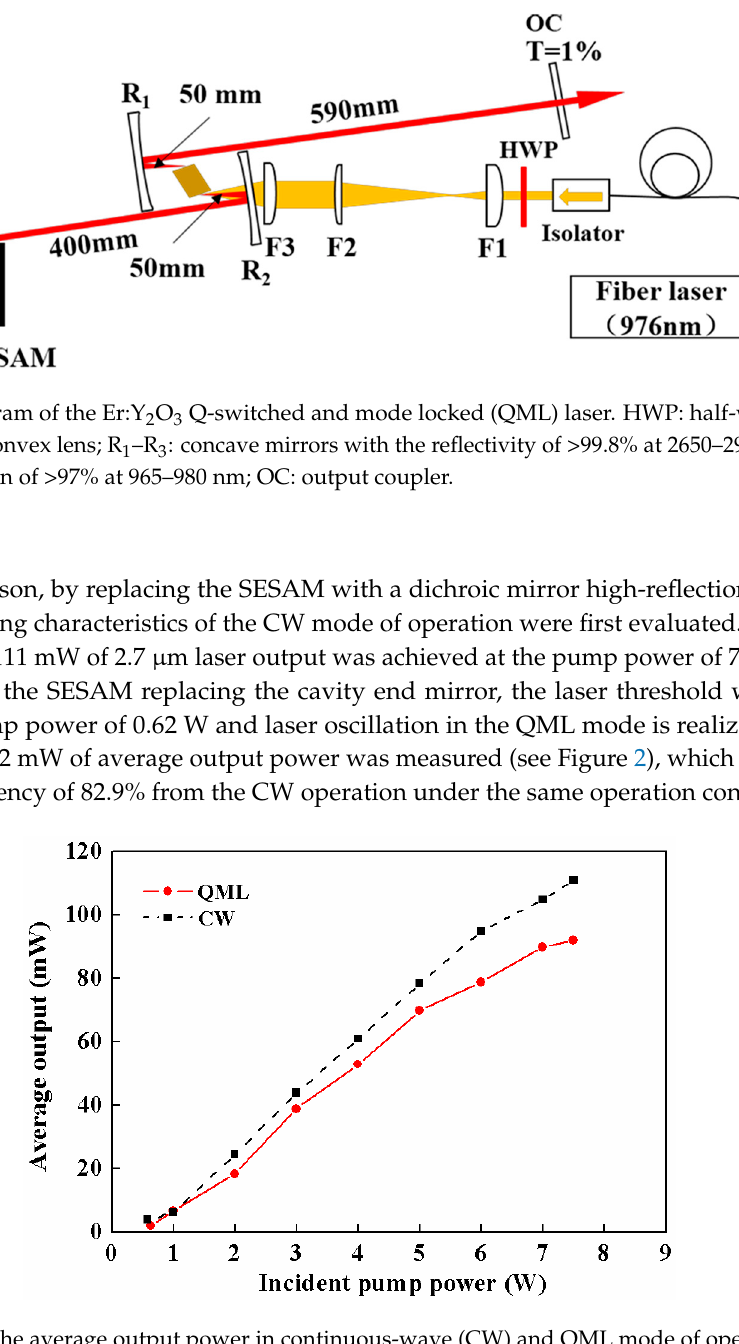
Figure 2. The average output power in continuous-wave (CW) and QML mode of operation.